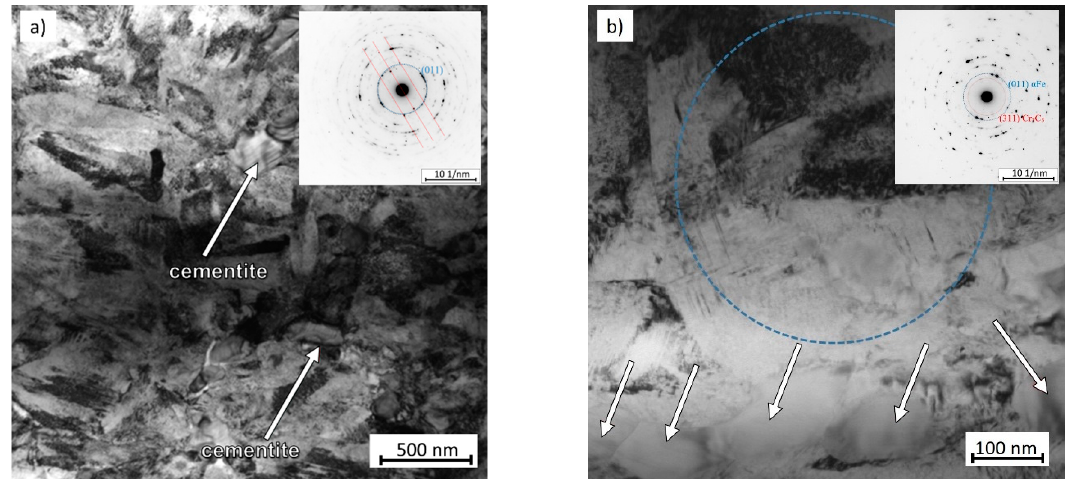
Figure 11. Regime 3: 1240 °C/water, BF micrograph: ( a ) fine-grained matrix with twinned martensite, retained austenite and Fe 3 C cementite particles; related SAED pattern with diffraction spots of α Fe ferrite (blue circle) and cementite (red); ( b ) ferrite region with locations of high dislocation density, sparse small carbide particles with a size of several nanometres, and undeformed cementite—arrows; the area examined using diffraction is indicated in blue; related SAED pattern with ferrite reflections and diffraction spots of hexagonal carbides indicated, the latter correspond to (311) planes in Cr 7 C 3.